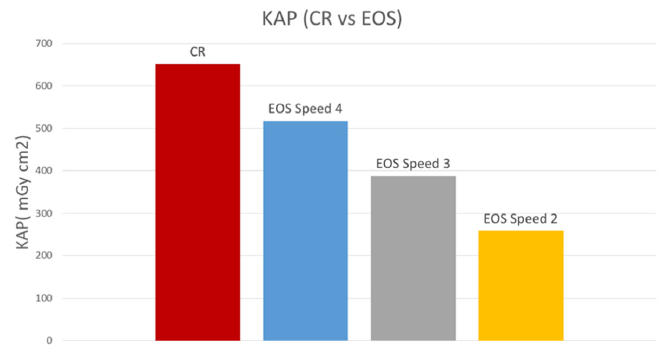
Figure 2. Bar graph illustrating the mean radiation dose by modality. CR = conventional radiographs and EOS = EOS imaging system at three different speed settings (speed 2 = 15.2 cm/s; speed 3 = 11.4 cm/s; speed 4 = 7.6 cm/s).